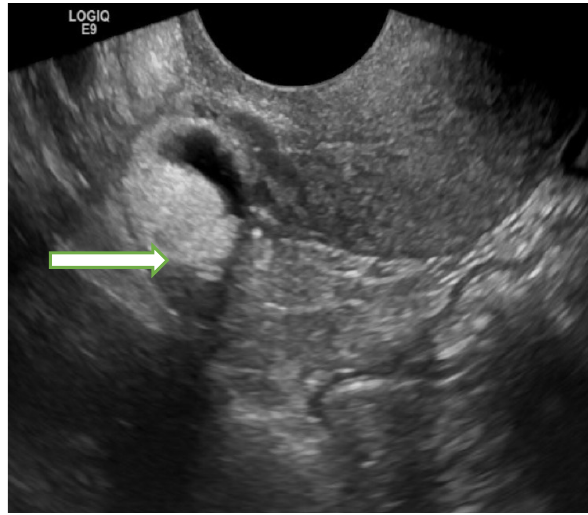
Figure 2. Transvaginal ultrasound image of the pelvis in a 55 years old lady shows a right adnexal 1.8 × 1.8 × 1.9 cm mass with mixed echogenicities (fat, calcification, and soft tissue) consistent with a dermoid cyst. The lesion remained stable in subsequent follow up studies confirming its benign